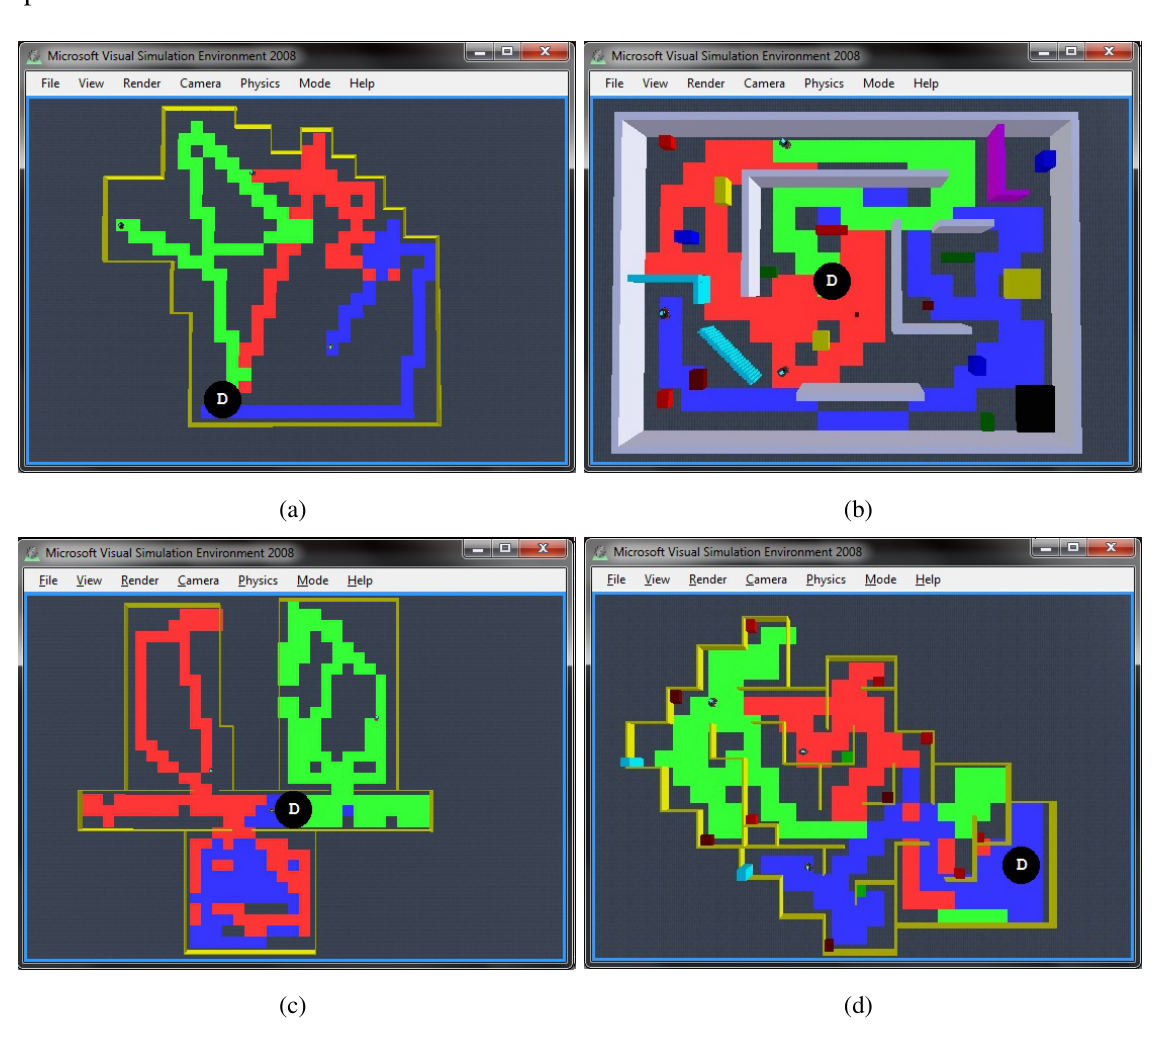
Figure 10. Multi-robot exploration simulation results, appropriate autonomous exploration within different environments including: ( a ) Open Areas; ( b ) Cluttered Environments; ( c ) Dead-end Corridors; ( d ) Minimum Exits. Black circle with D indicates deployment